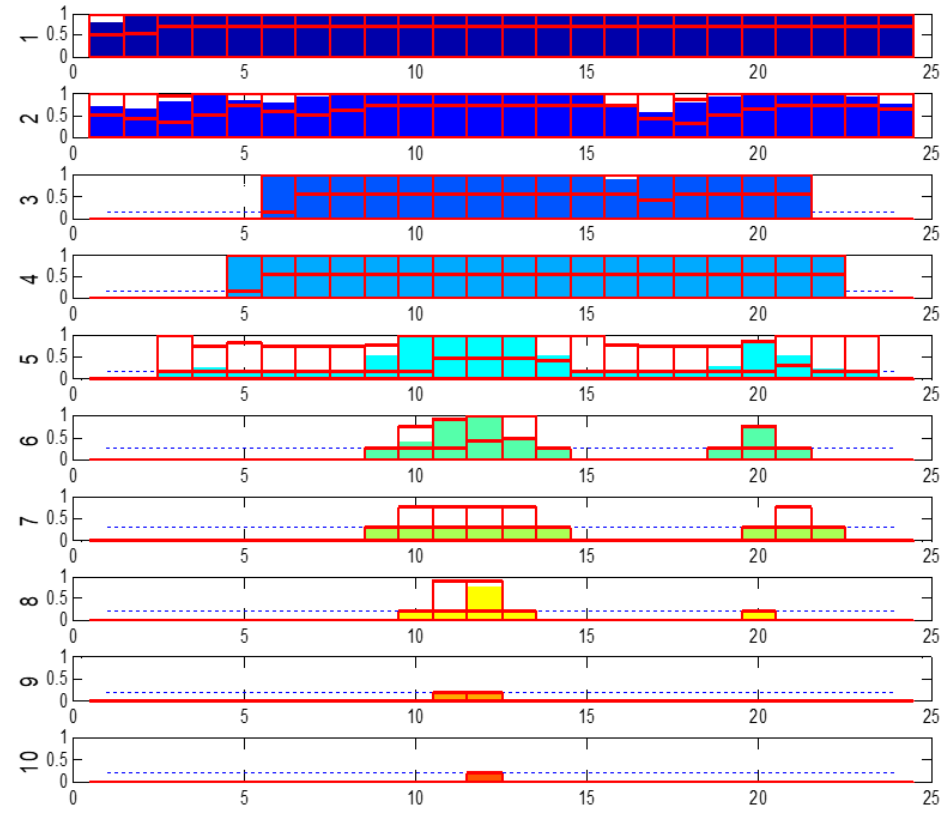
Figure 4. Unit commitment and load factor of the 10-unit problem for case 1.